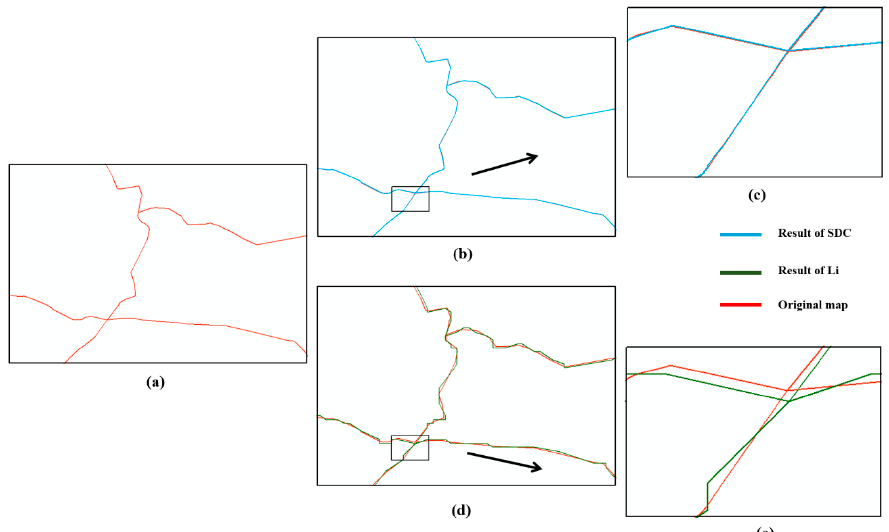
Figure 10. Overlaid results of maps at di ff erent scales. ( a ) is the original map at a scale of 1:100,000; ( b ) is the compression map at the scale of 1:100,000 using the new algorithm and n is 15. ( c ) is the compression map zooming to a scale of 1:25,000 using the new algorithm ( d ) is the compression map at the scale of 1:100,000 using Li’s method. ( e ) is the compression map zooming to a scale of 1:25,000 using Li’s